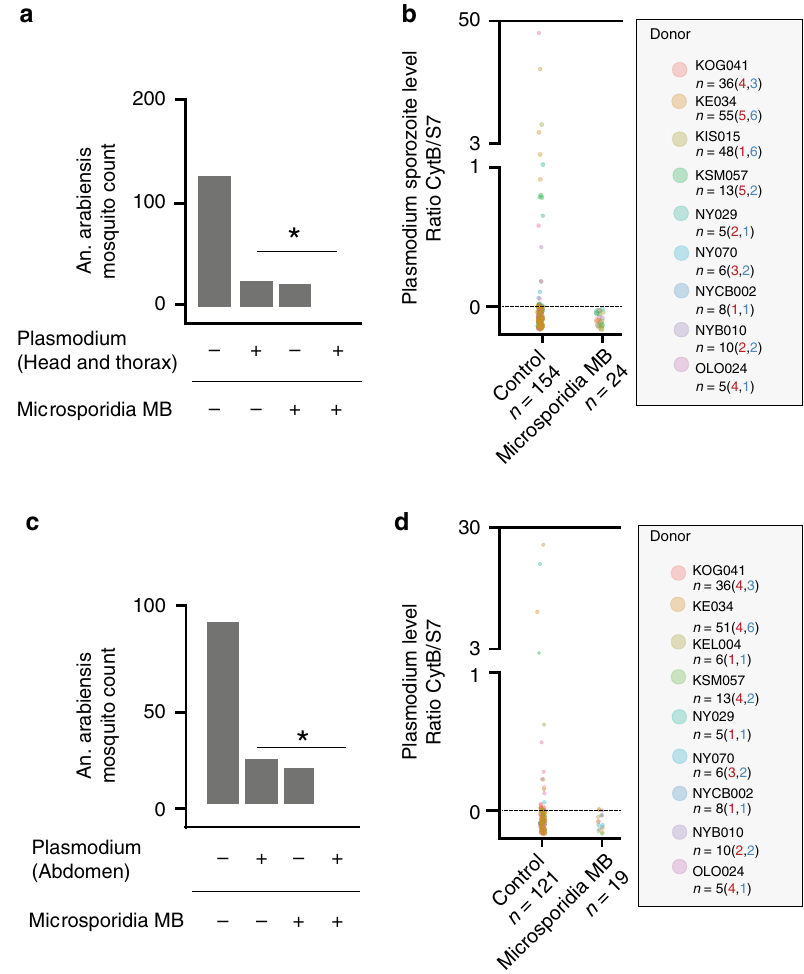
Fig. 4 Microsporidia MB impairs parasite development in An. arabiensis after direct membrane feeding assay challenge with P. falciparum . The Plasmodium infection rate in Microsporidia MB positive and Microsporidia MB negative mosquitoes was determined by qPCR. a The head and thorax Plasmodium infection rate, re fl ecting presence of sporozoites, in Microsporidia MB positive and Microsporidia MB negative mosquitoes. There was a signi fi cant absence of co-infected mosquitoes (two-tailed fi sher exact test, P = 0.02 n = 178). b Plasmodium intensity in An. arabiensis heads and thoraxes, quanti fi ed by qPCR. c The abdomen Plasmodium infection rate, re fl ecting presence of oocysts, in Microsporidia MB positive and Microsporidia MB negative mosquitoes. There was a signi fi cant absence of co-infected mosquitoes (two-tailed fi sher exact test, P = 0.04, n = 140). d Plasmodium intensity in An. arabiensis abdomens, quanti fi ed by qPCR. Data shown in ( a , b , c , d ) are pooled from replicate experiments carried out using different gametocyte donors (for each donor the numbers of Plasmodium positive An. arabiensis is shown in red and Microsporidia MB positives An. arabiensis is shown in blue). Each data point is an individual An. arabiensis mosquito. Source data are provided as a Source Data fi